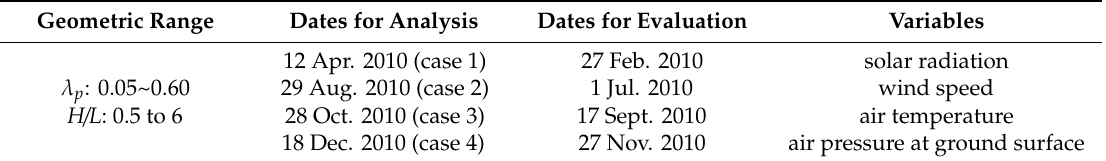
Table 2. Numerical experiments with Temperatures of Urban Facets in 3-D (TUF-3D): geometric conditions and input data. Geometric Range Dates for Analysis Dates for Evaluation Variables λ p :